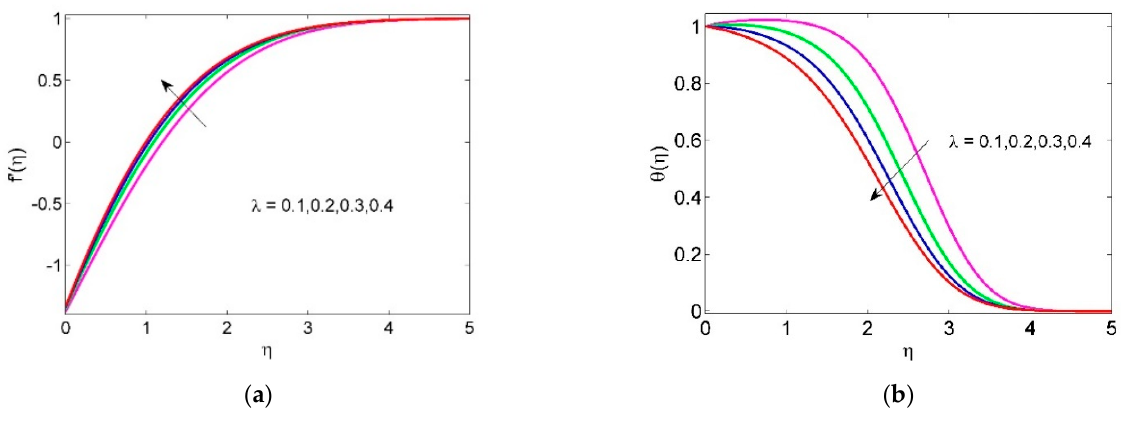
Figure 3. Impacts of λ on 𝑓 ′ (𝜂) and 𝜃(𝜂) .